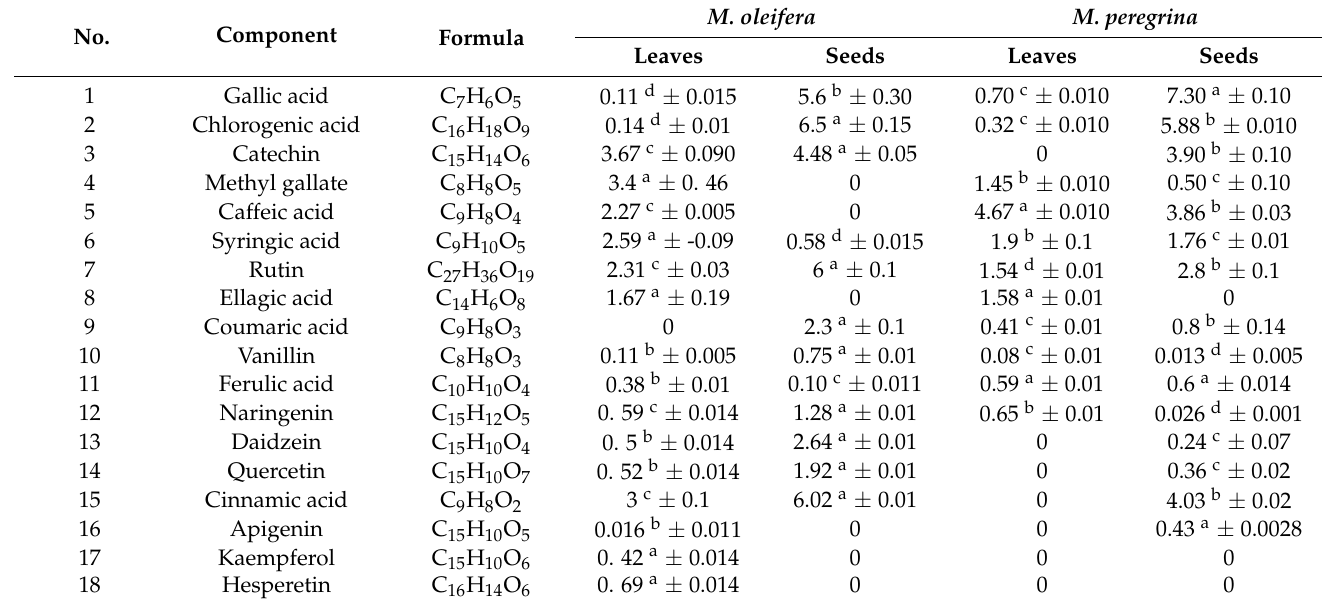
Table 4. Polyphenols composition (%) from leaves and seeds of M. oleifera and M. peregrina